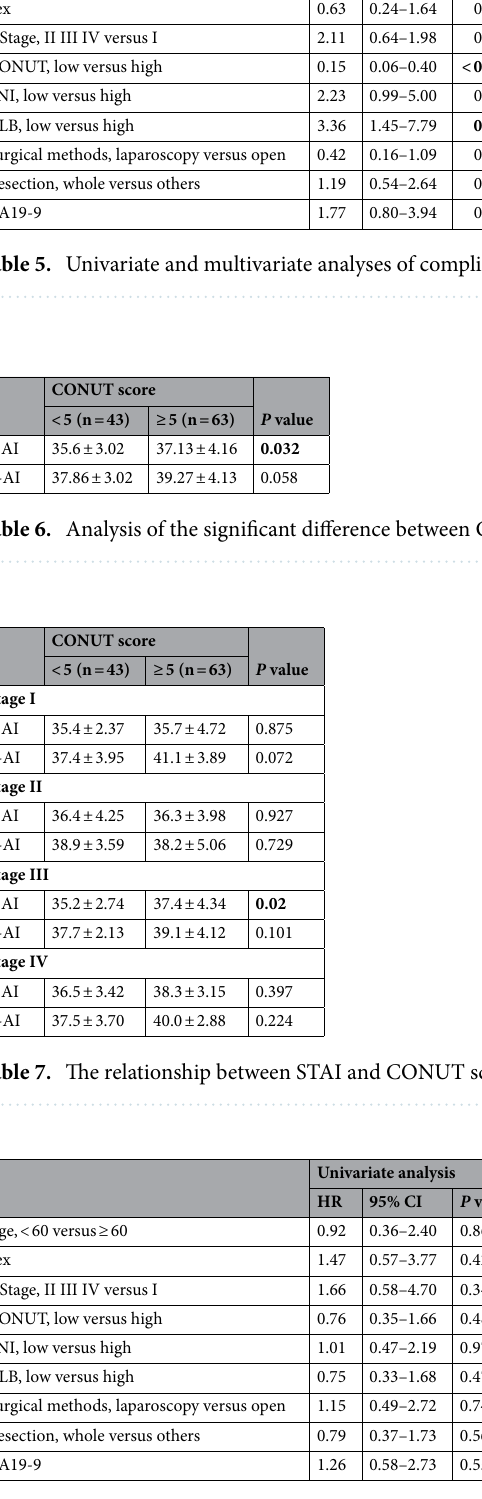
Table 8. Logistic regression analysis of independent risk factors for